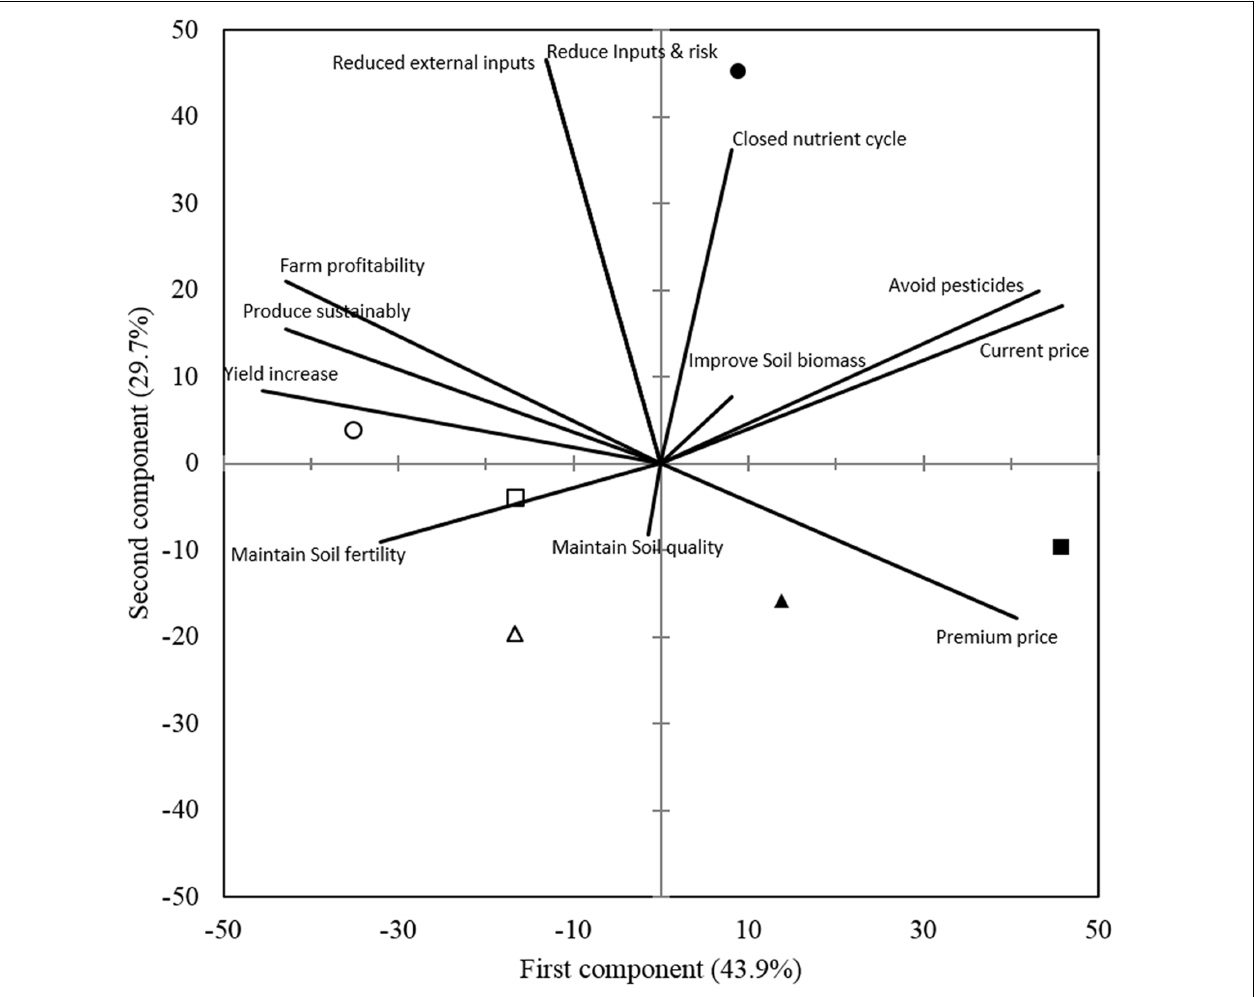
FIGURE 5 | Biplot from the principal component analysis of the biophysical factors influencing the adoption of specific practices by